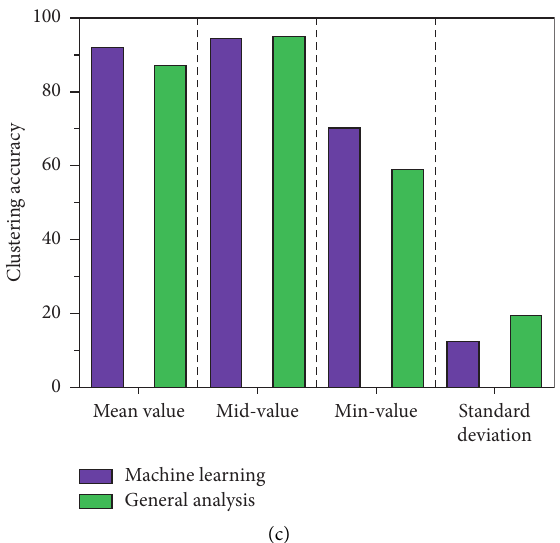
Figure 10: Clustering accuracy analysis of different methods in simulation data set: (a) noise � 0.70, (b) noise � 0.75, and (c) noise �